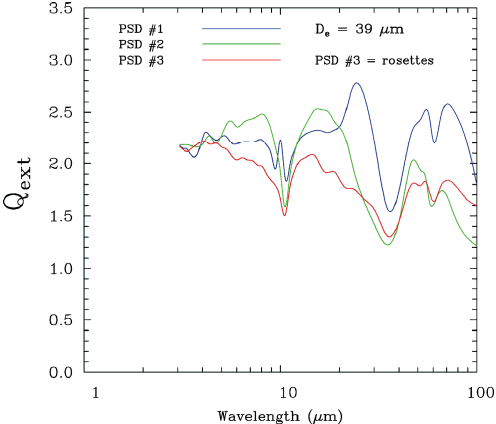
Figure 7. Wavelength dependence of Q ext for the 3 PSD described in Fig. 4, using the same color convention. All PSD have the same D e and IWC.